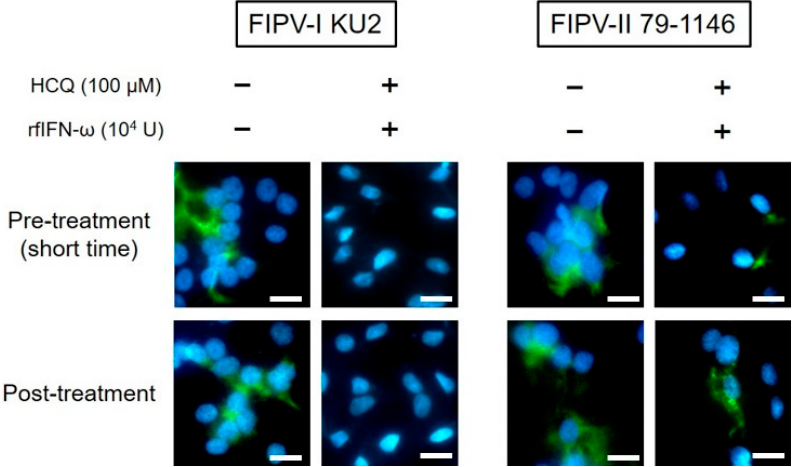
Figure 5. Effects of HCQ and rfIFN- ω on FIPV N protein expression. FIPV N protein was evaluated by IFA. Scale bar = 10 μ m.